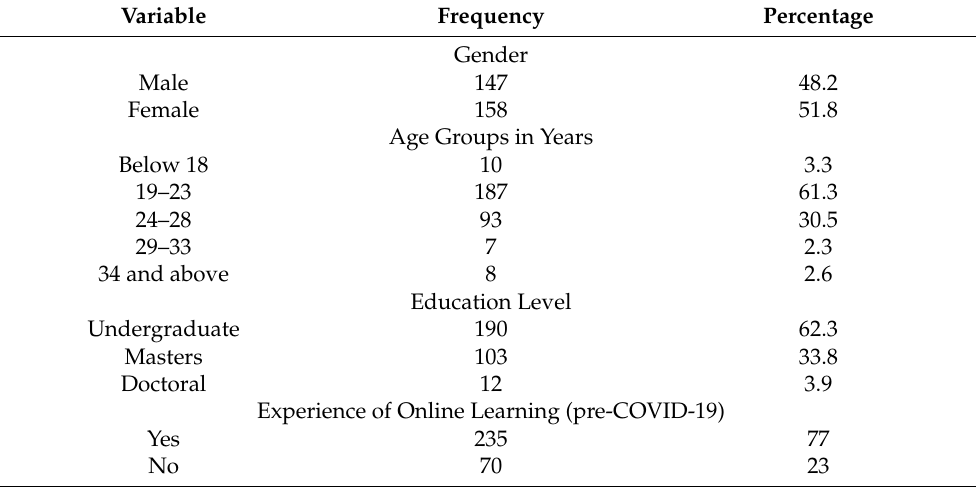
Table 1. Socio-demographic Characteristics of respondents.